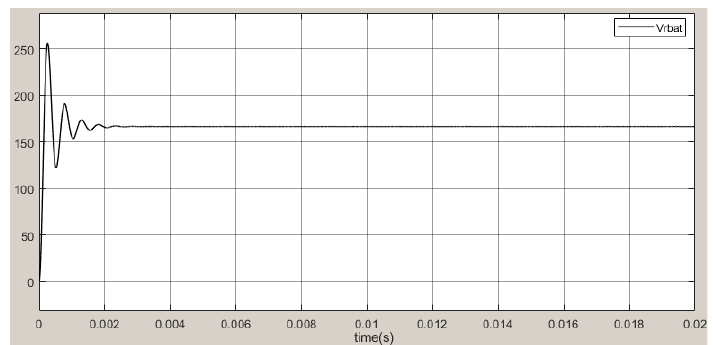
Figure 14. Charging voltage of battery port.